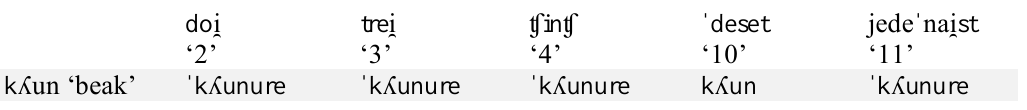
Table 4. ‘Ten’ as threshold for neutralization of number oppositions